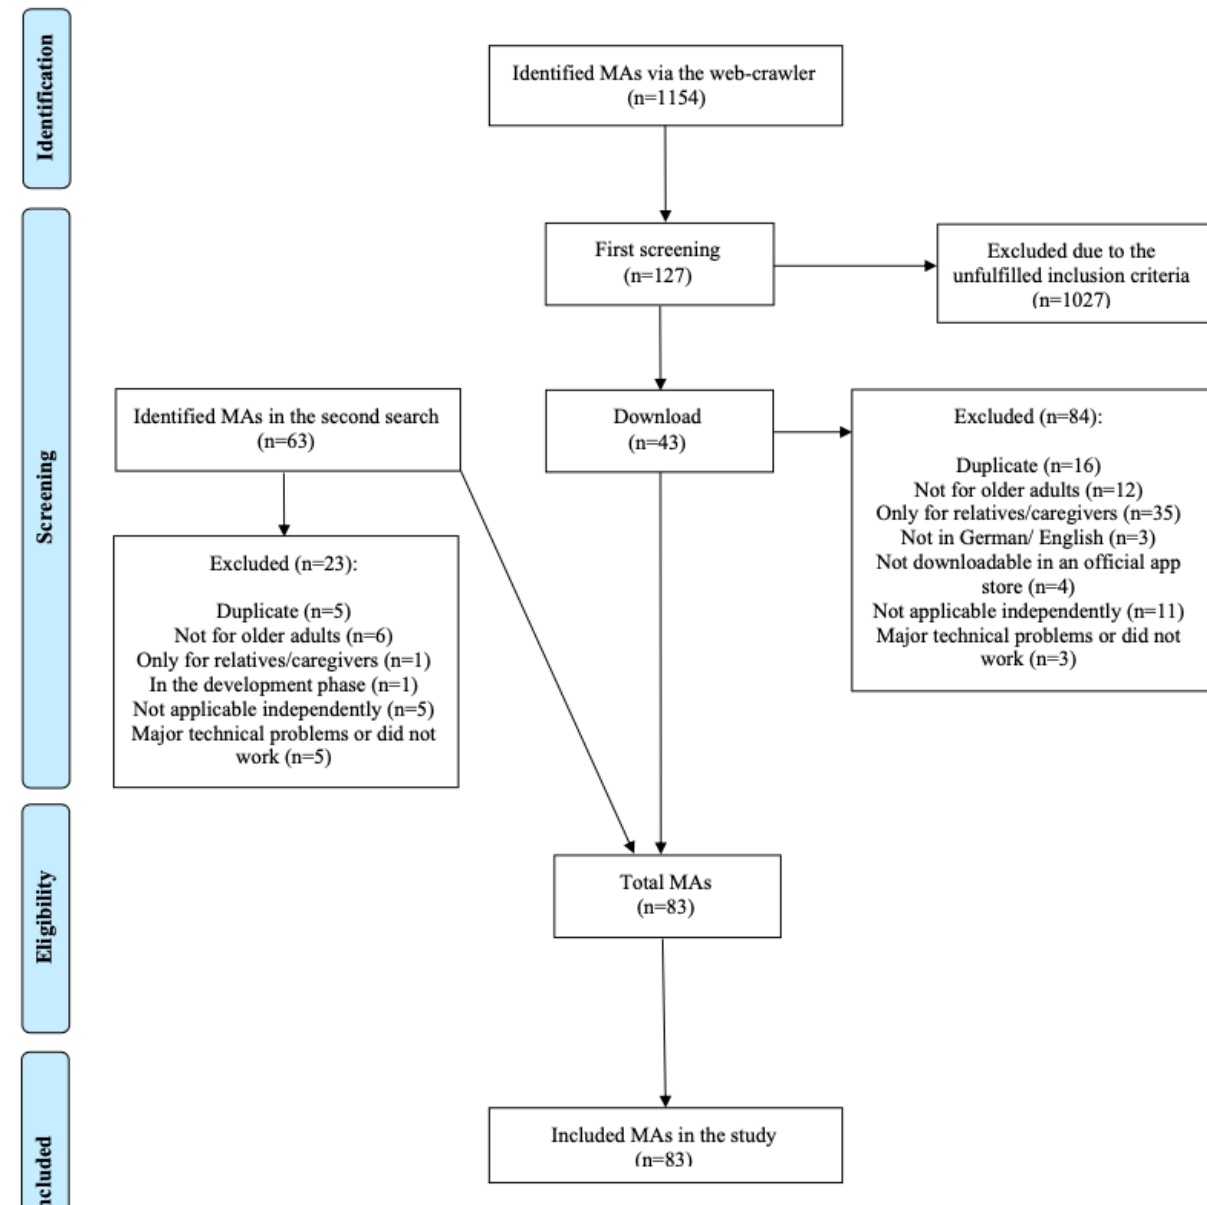
Figure 1. Flowchart of the mobile app selection